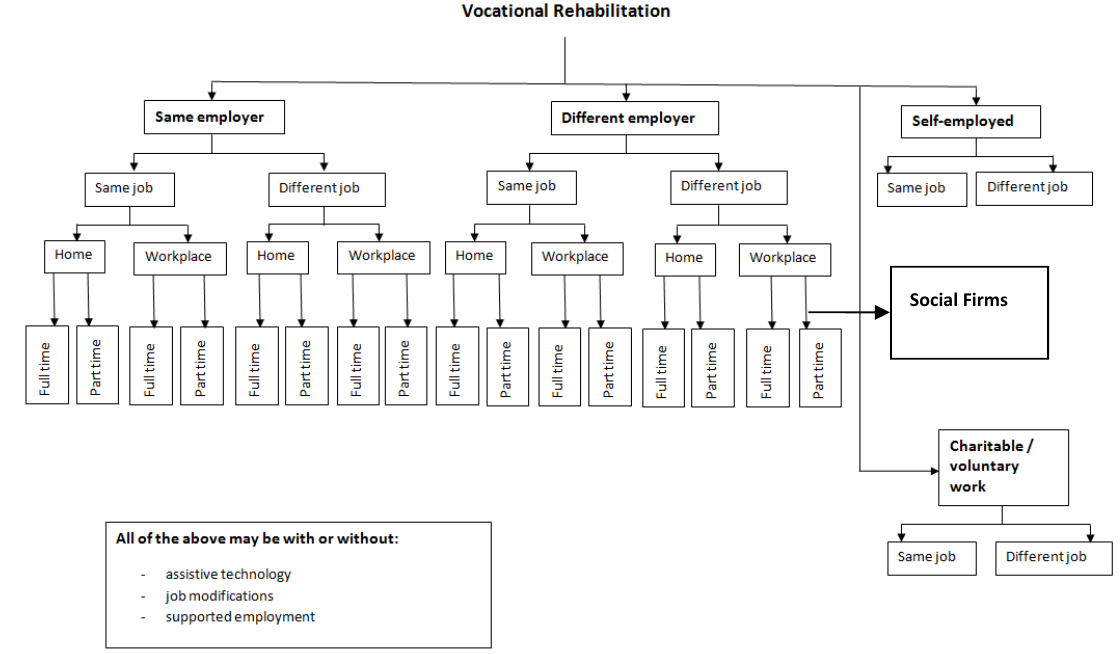
Figure 2. Suggested routes to help individuals back into work.